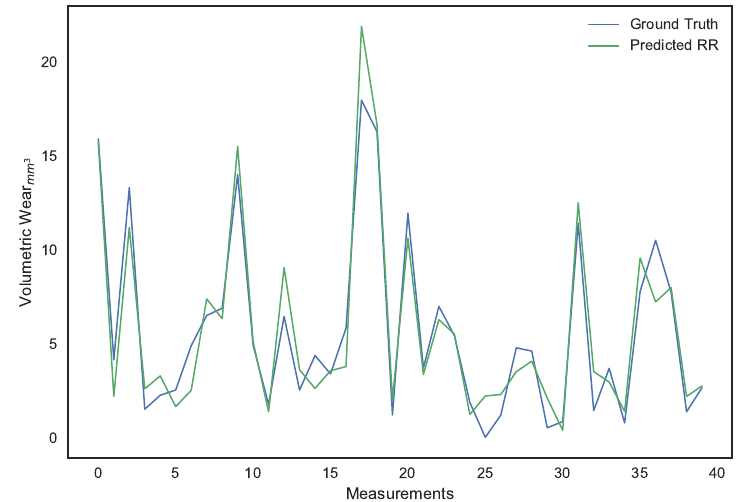
Figure 13. Surface wear prediction on the validation set using ridge regression.